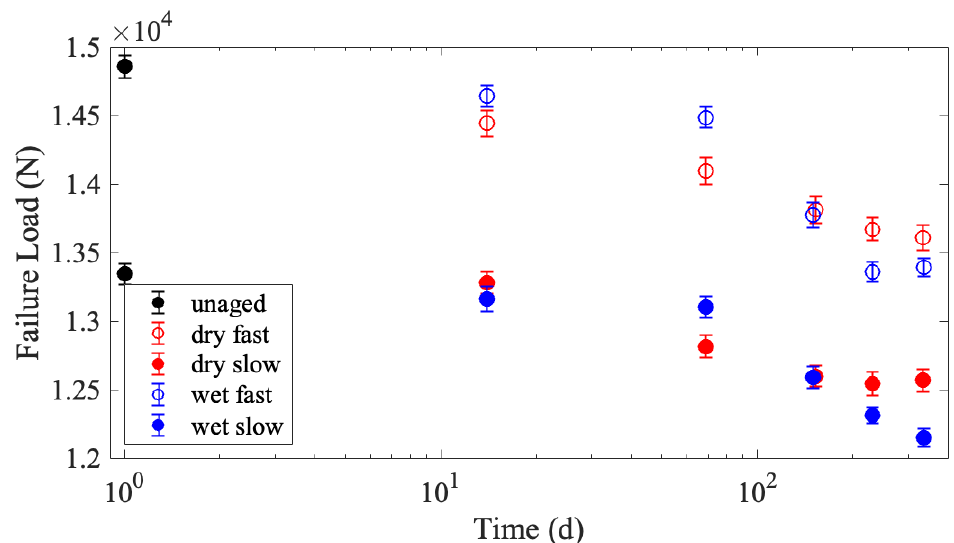
Figure 5. Mean failure load (in Newtons) as a function of days aged, where error bars represent the standard error of the mean ( n ≥ 50). Specimens are all 70 mm wide with a gauge length of 250 mm, tested at either 250 mm/min (fast – open circles) or 2 mm/min (slow – filled circles). Aging was performed at 70 °C either in a desiccator (dry – red coloring) or at 76% relative humidity (wet – blue coloring).